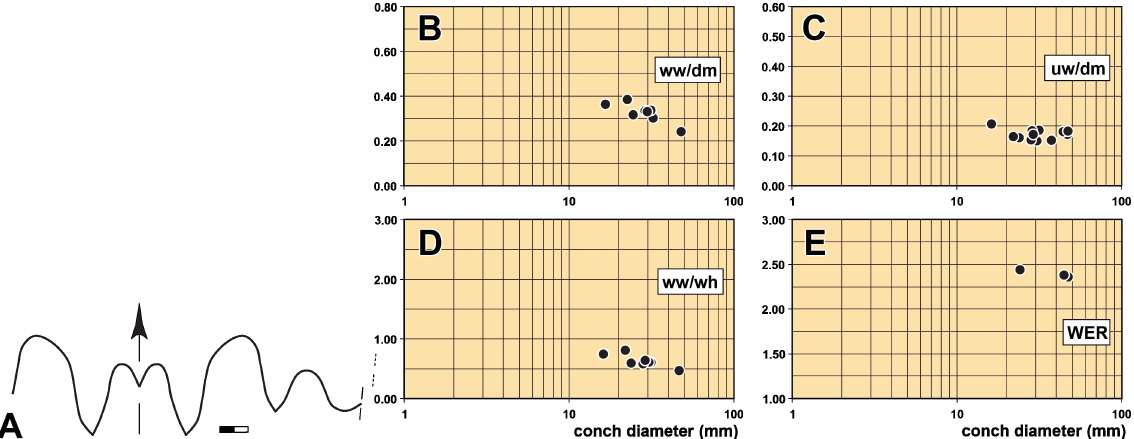
Fig. 14. Darkaoceras galeatum (Matern, 1931). A . Suture line of specimen MB.C.3633 (Ahlburg Coll.) from Oberscheld (Königszug Mine), at ww = 10.7 mm, wh = 16.5 mm. B–E . Ontogenetic trajectories of the cardinal conch parameters. Scale bar units =